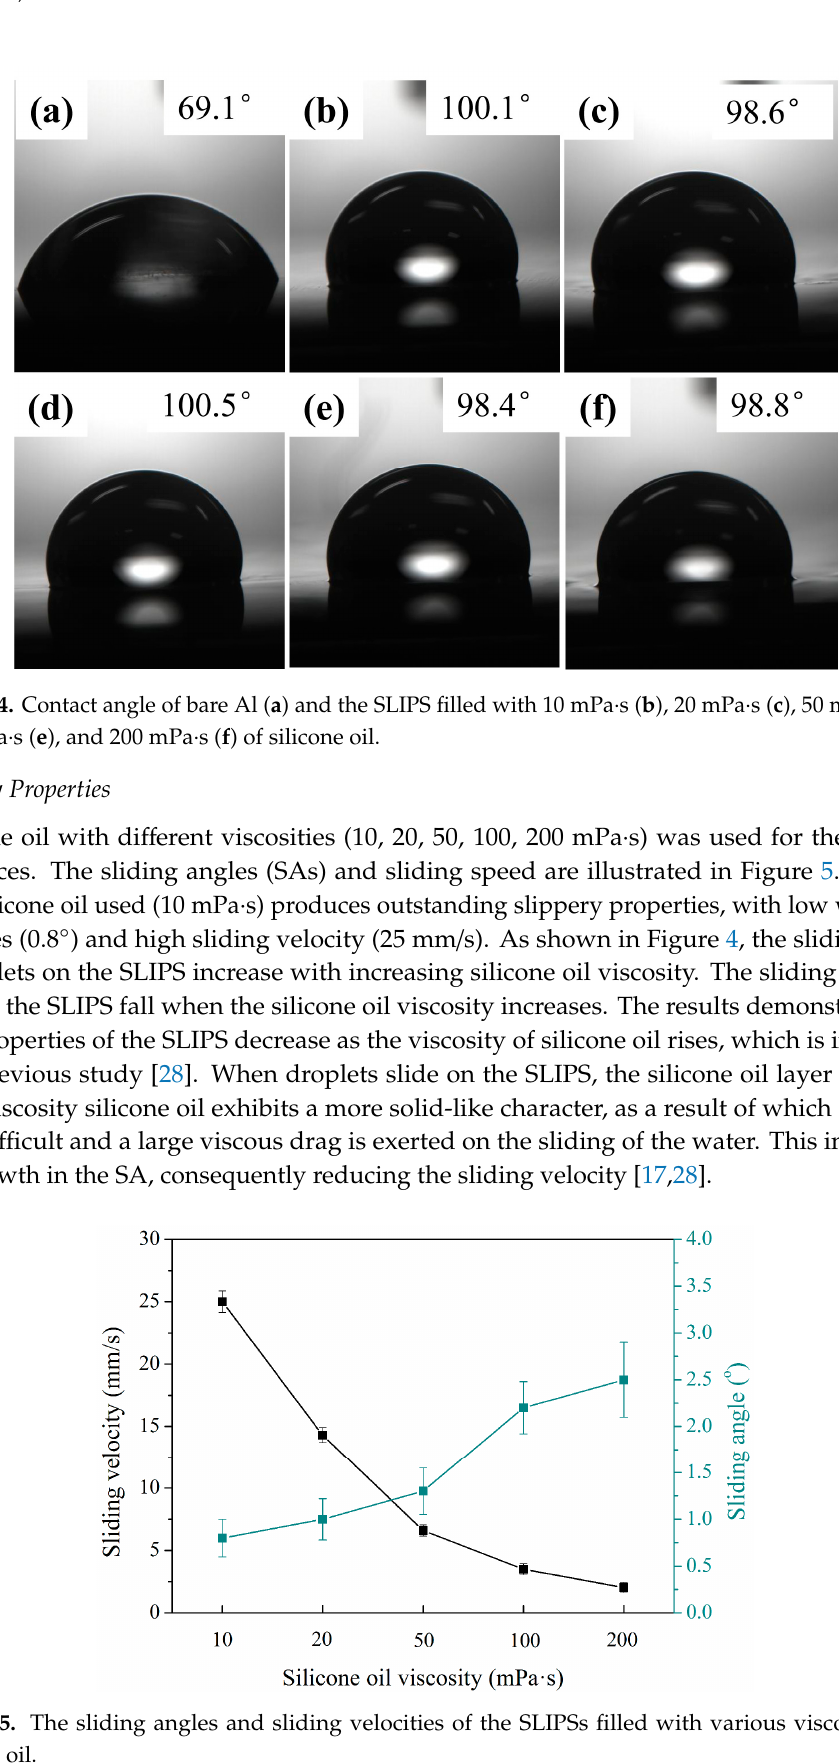
Figure 3. Cross-section of AAO before ( a ) and after ( b ) infusion of the silicone oil. The inset shows the EDS mapping images of silicon. ( c ) EDS spectra of the cross-section of AAO before and after infusion of 200 mPa·s silicone oil.